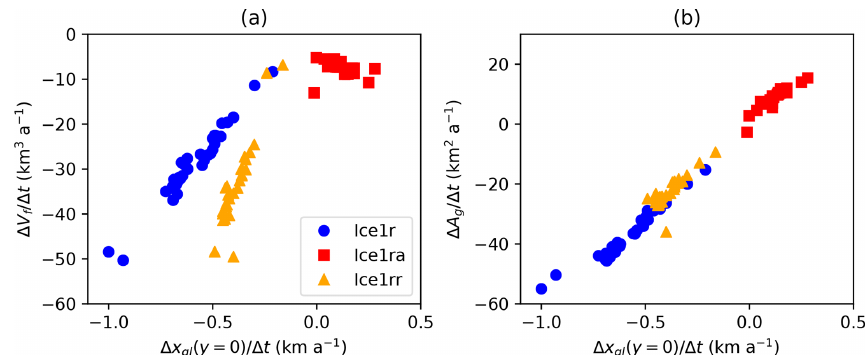
(cid:16) (cid:49)x (cid:17) gl (y = 0 ) , (cid:49)V f lies close to a straight line, (cid:49)t (cid:49)t